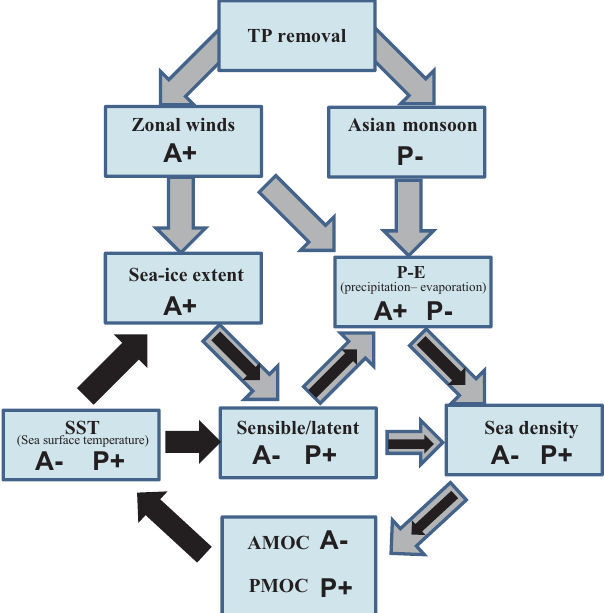
Figure 8. Schematic diagram about the influence of the removal of TP on the AMOC and PMOC. Vectors in gray denote the cli- mate responses in relation to the increased wind-induced and de- creased monsoonal-driven net precipitation–evaporation and wind- driven sea-ice processes. The black vectors denote the feedback pro- cesses. The bold characters A and P stand for the physical processes occurring over the North Atlantic and Pacific,